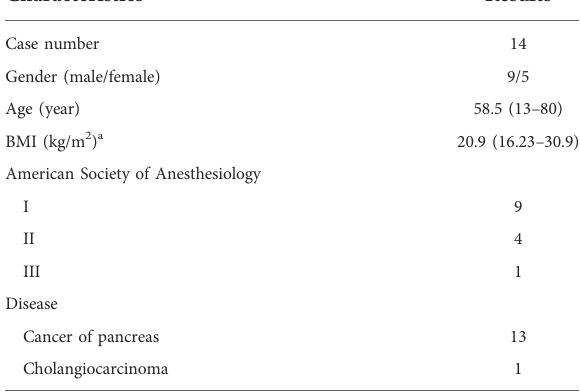
TABLE 1 Patient characteristics data.